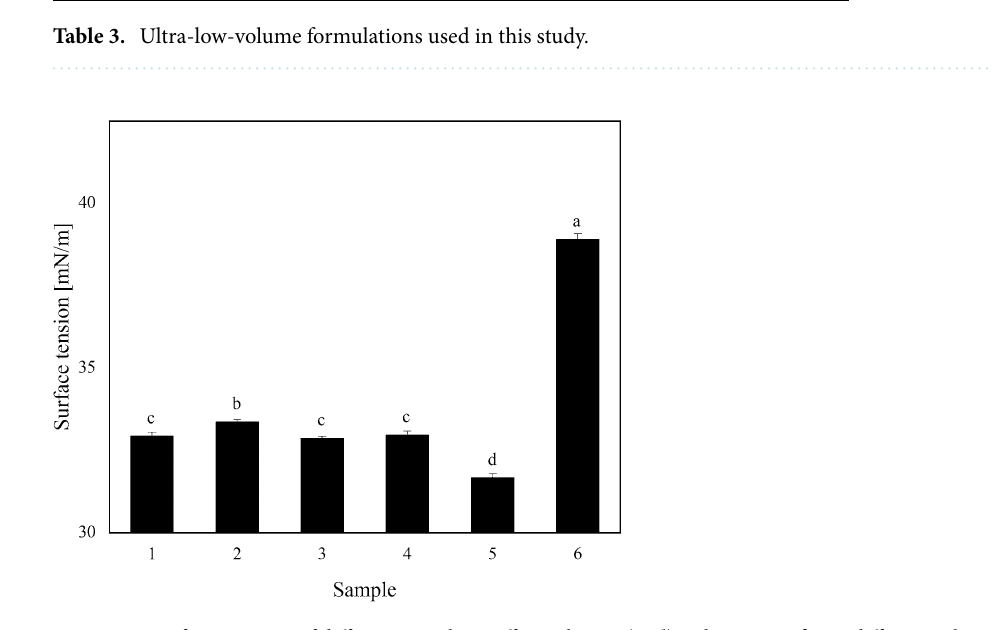
Figure 1. Surface tensions of different samples. Different letters ( a – d ) indicate significant differences between means. Means followed by the same letter are not significant at the 5% significance level by the LSD test (LSD = 0.05). Vertical bars indicate a standard deviation of the mean. The detailed data of the histogram is shown in Supplementary Table